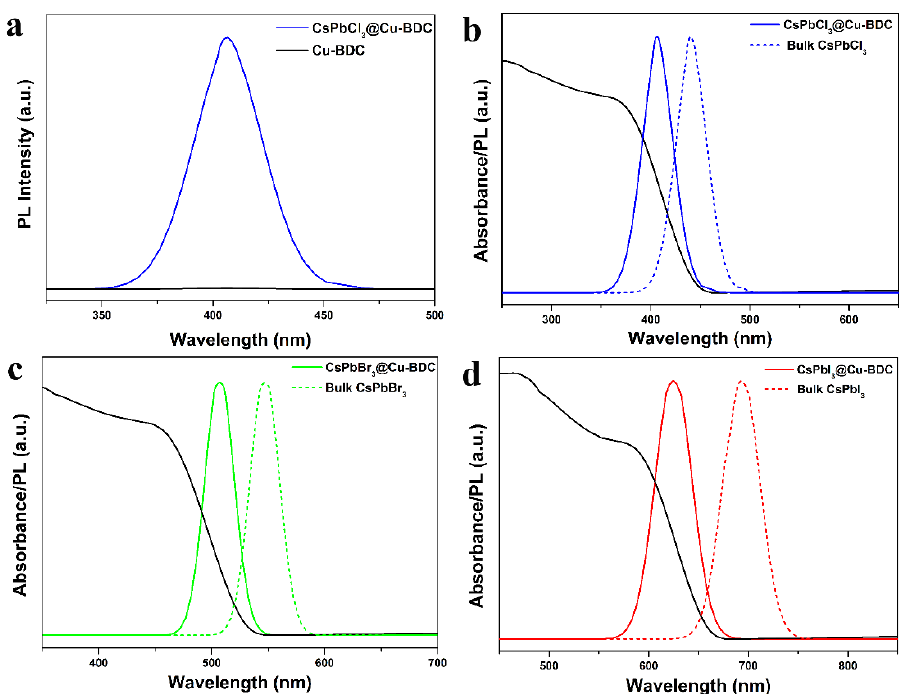
Figure 6. ( a ) PL spectrum of Cu-BDC and CsPbCl 3 @Cu-BDC; the UV-vis absorption spectrum and PL spectrum of ( b ) CsPbCl 3 @Cu-BDC and bulk CsPbCl 3 , ( c ) CsPbBr 3 @Cu-BDC and bulk CsPbBr 3 , and ( d ) CsPbI 3 @Cu-BDC and bulk CsPbI 3 .